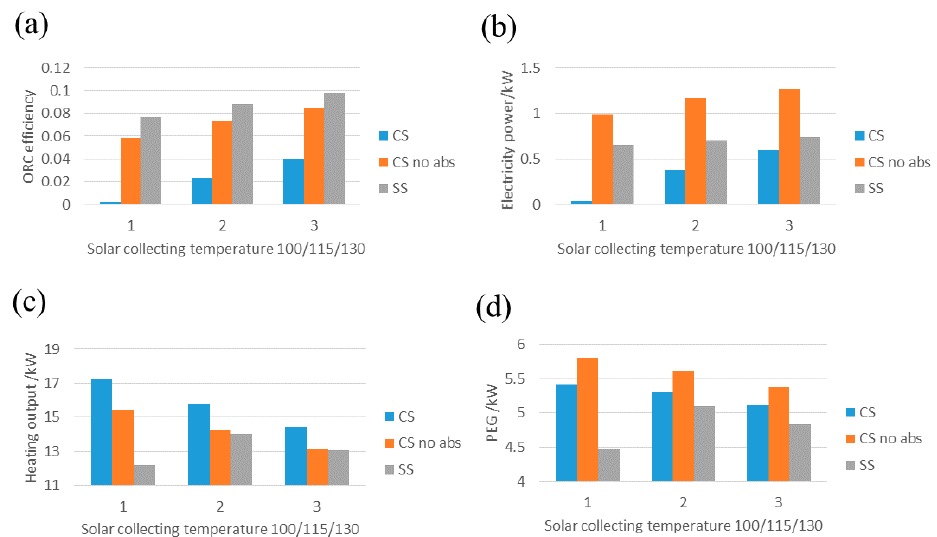
Figure 9. ( a ) ORC efficiency, ( b ) cooling output capacity, ( c ) electricity generation and ( d ) primary energy efficiency for the CCHP systems under different solar collecting temperature with R1233zd as ORC working fluids in heating mode.